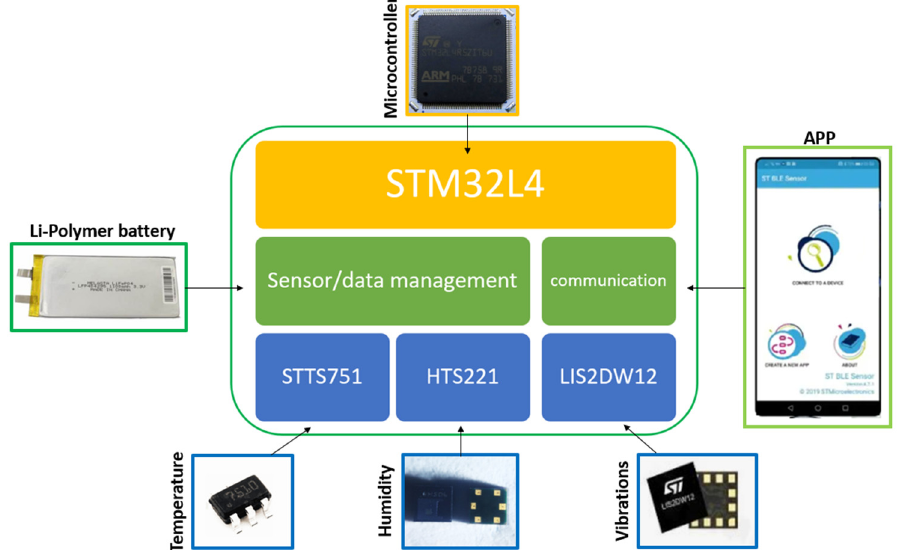
Figure 2. Schematic diagram of the IoT-based system for microclimate monitoring. Table 2. Characteristic of the